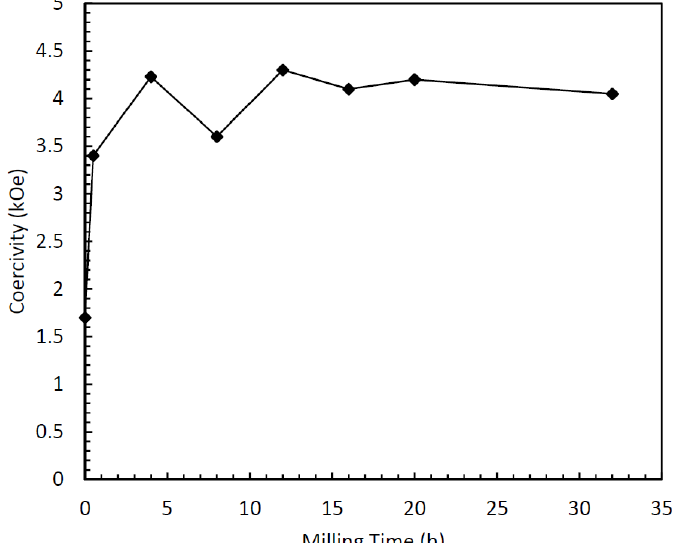
Figure 10. Relationship between surfactant-assisted milling time and coercivity.